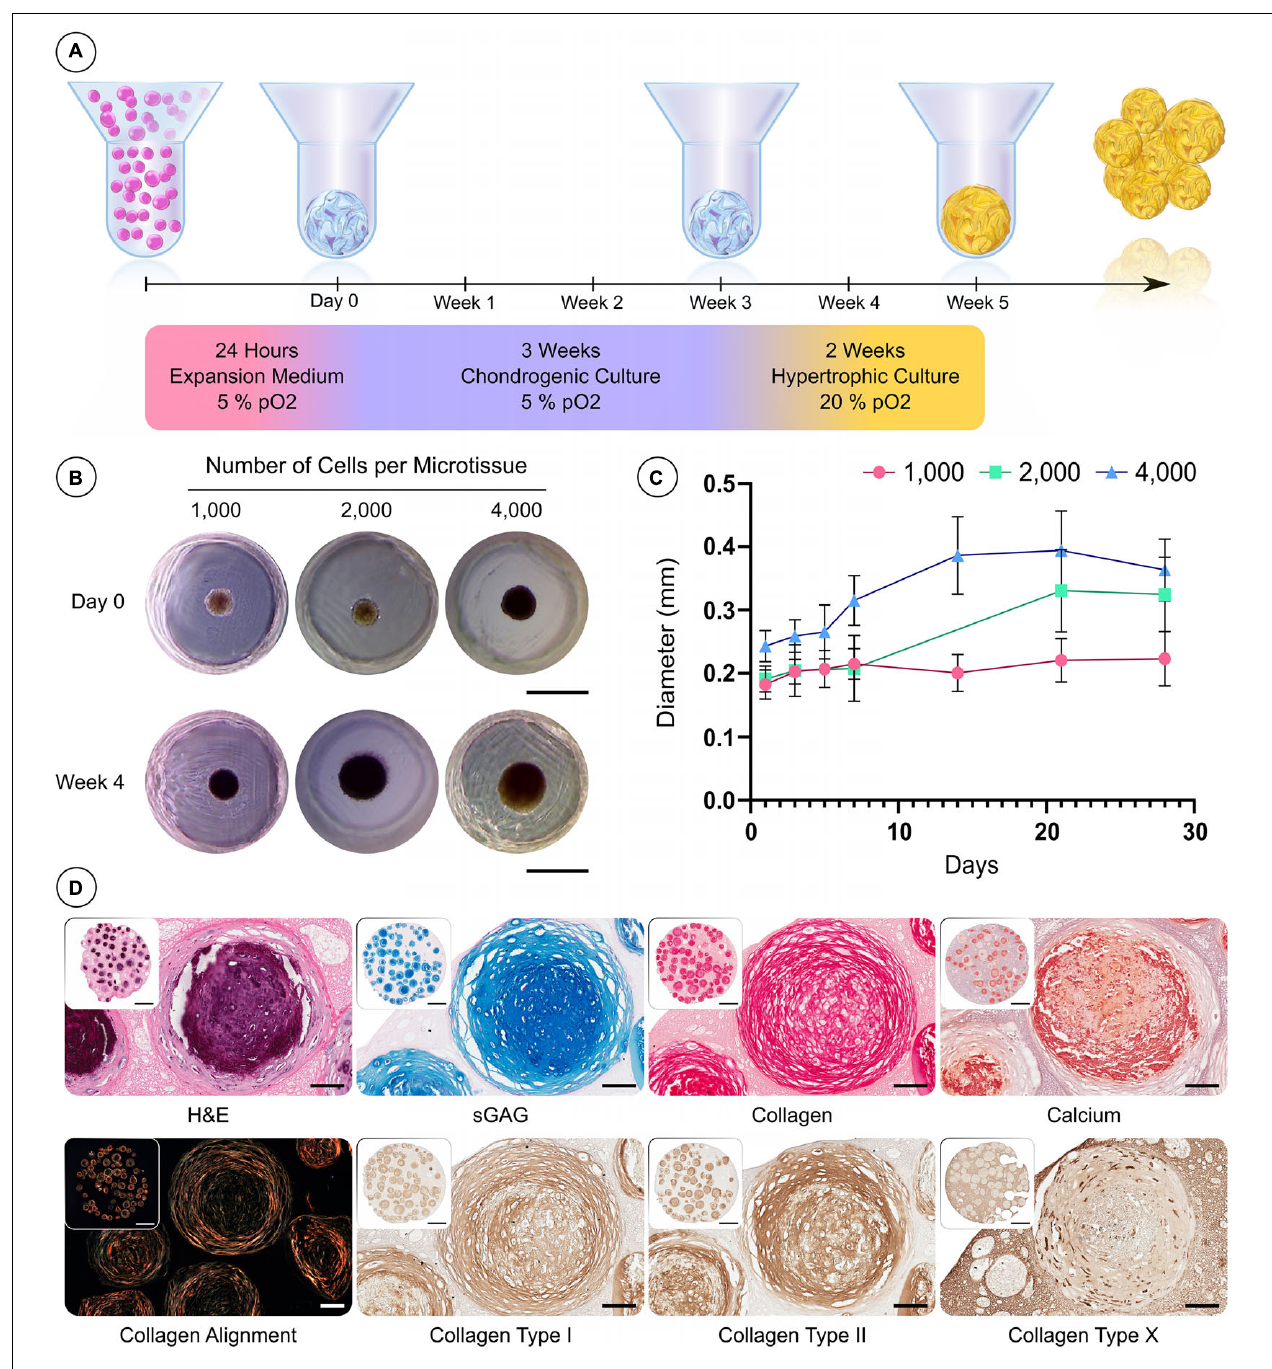
FIGURE 3 | Custom microwell design supports the formation of hBMSC spheroids and their differentiation into hypertrophic cartilage microtissues. (A) Schematic of the culture regime employed to generate hypertrophic cartilage microtissue. (B) Visual comparison of microtissue diameter of 1,000, 2,000, and 4,000 cells/microtissues at 24 h and 28 days. (C) Growth curve of microtissues over 28 days ( n = 48, Mean ± SD). (D) Histological evaluation of microtissues after 5 weeks hypertrophic priming (from left to right—row 1) hematoxylin and eosin (H&E) staining, alcian blue staining, picrosirius red staining and finally alizarin red staining. Row 2—Polarised light microscopy, immunohistochemistry (Scale bar of inset image = 1 mm and high mag image = 100 µ m).